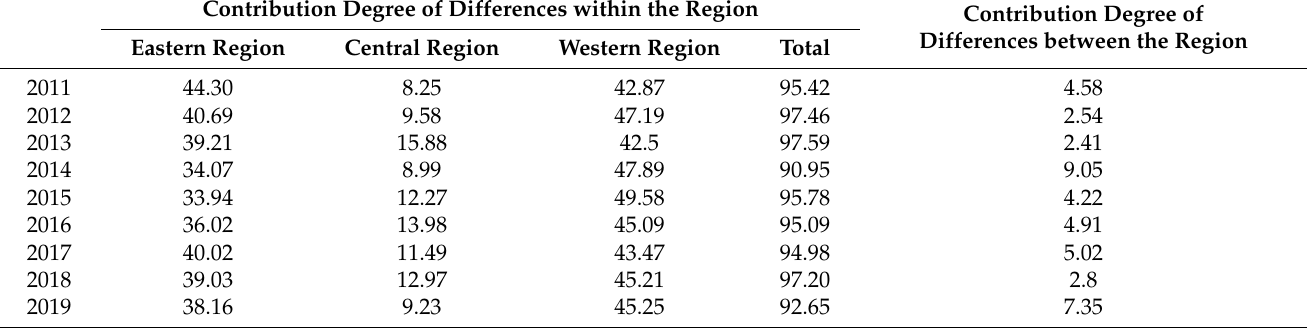
Table 2. Contribution degree of each regional mortality differences on national total differences (unit: